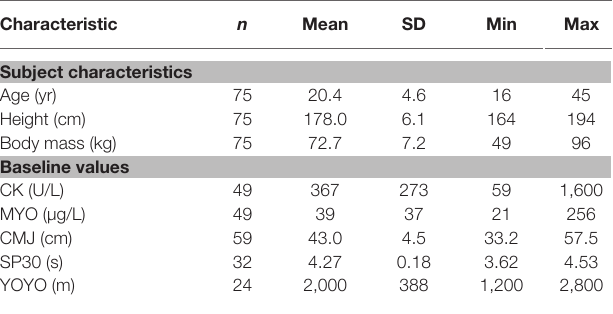
TABLE 1 | Summary of subject characteristics and baseline values for recovery